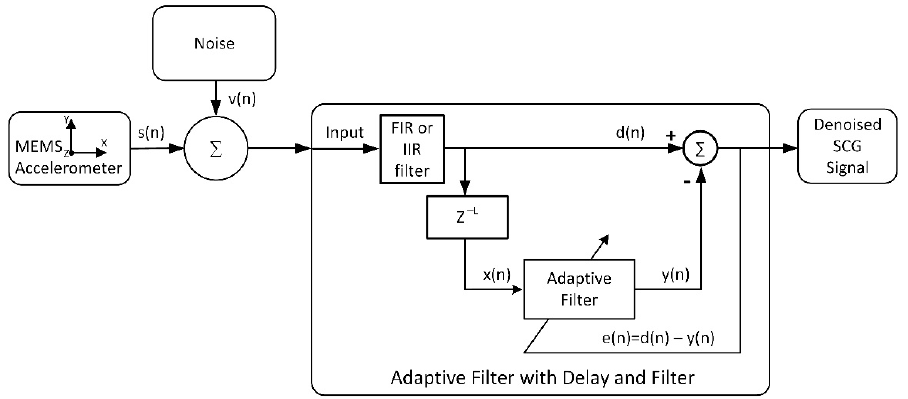
Figure 7. Adaptive filter configuration. Where: s(n)—input signal, x(n)—delayed signal, d(n)—de ‐ sired signal, e(n)—adaptation error, y(n)—denoised signal, v(n) noise signal.